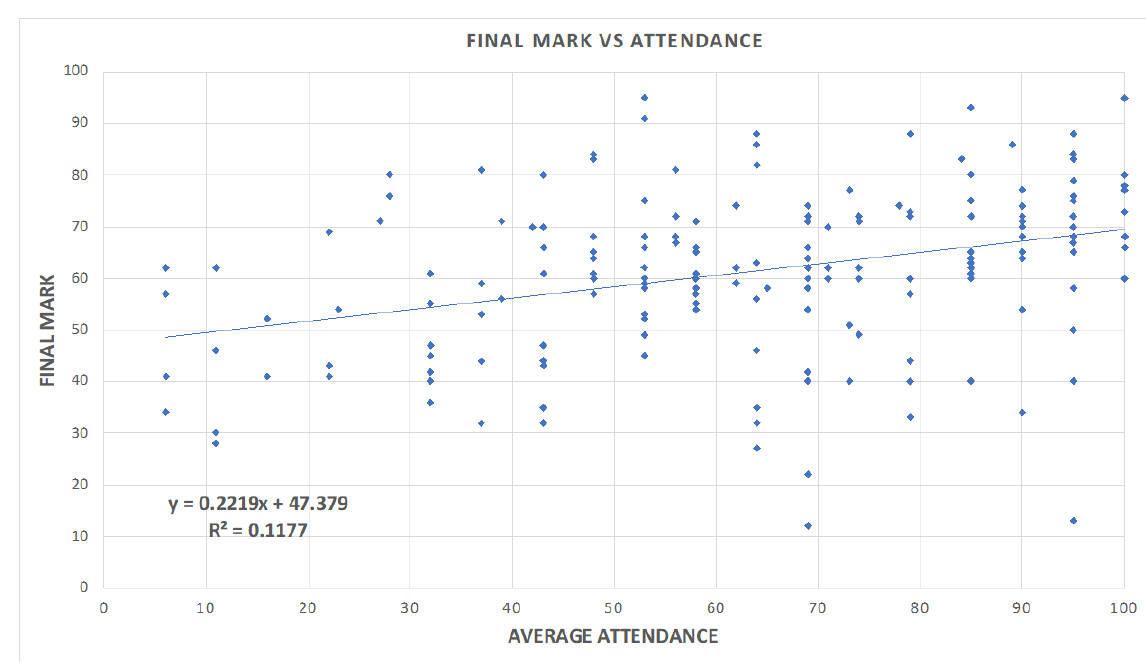
Figure 2 . Final Mark vs Attendance